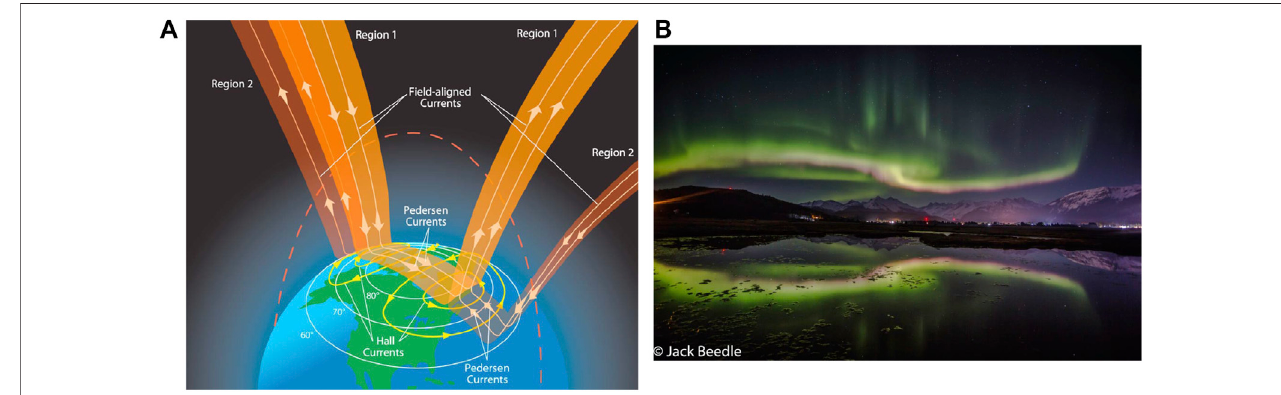
FIGURE 12 | (A) Diagram from Le et al. (2010) representing how FACs connect the outer magnetosphere and the ionosphere, where the ionosphere ’ s conductance allows the current systems to close through the Pedersen currents. (B) Image of the Northern Lights captured over Southeast Alaska, which shows the Northern Lights ’ characteristic green curtains (Beedle, 2021).